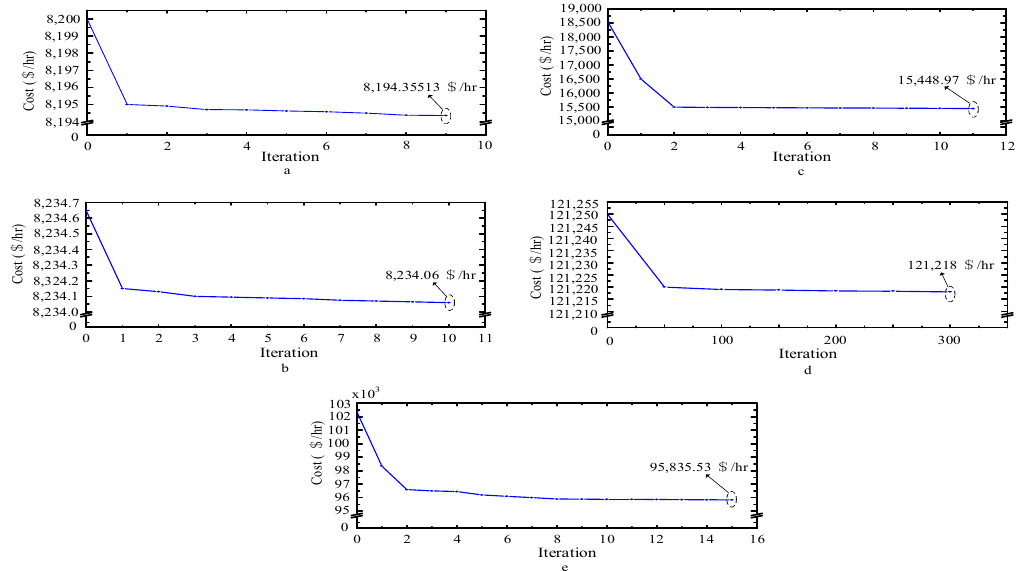
12 of 17 Figure 3. The accuracy of the MIW-PSO: ( a ) first case study; ( b ) second case study; ( c ) third case study; ( d ) fourth case study; ( e ) fifth case study. To validate accuracy of the MIW-PSO getting the optimal total cost, we computed the MIW-PSO in 100 trials. Figure 3 shows the accuracy validation of the MIW-PSO. Figure 3a represent the accuracy of the MIW-PSO in the first case study. MIW-PSO yields smaller generation cost deviation to obtain the optimal total cost, which is 8194.35513 $⁄hr. A similar thing is shown in Figures 3b–e, which